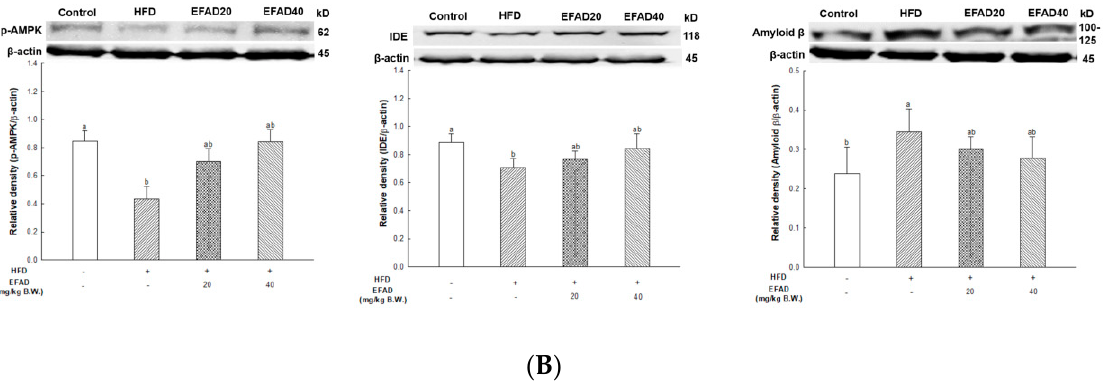
Figure 8. Effect of ethyl acetate fraction from Aruncus dioicus var. kamtschaticus (EFAD) against central nerve system-insulin resistance induced by HFD. (A) Expression degrees of p-IRS(ser307), p-Akt, and p-tau in brain tissue. (B) Expression degrees of p-AMPK, IDE, and amyloid β in brain tissue. The values shown are as mean ± SD ( n =3). The data were statistically considered at p < 0.05 and they were represented as different small letters.